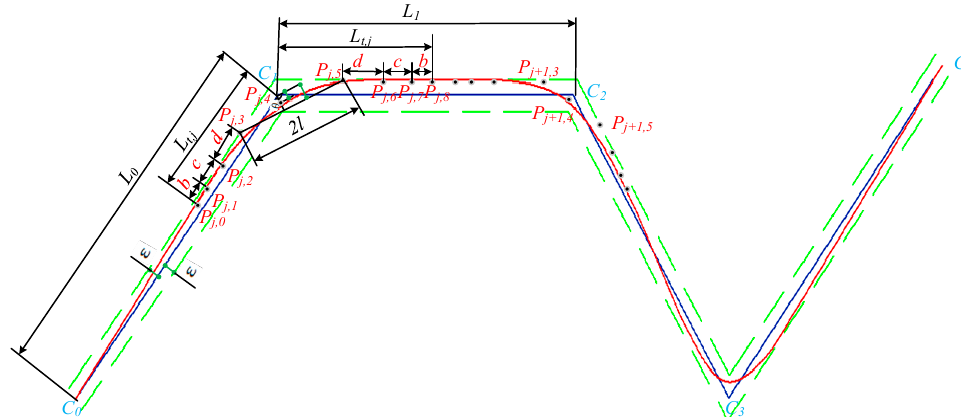
Figure 1. The distribution of corner-smoothing curve.